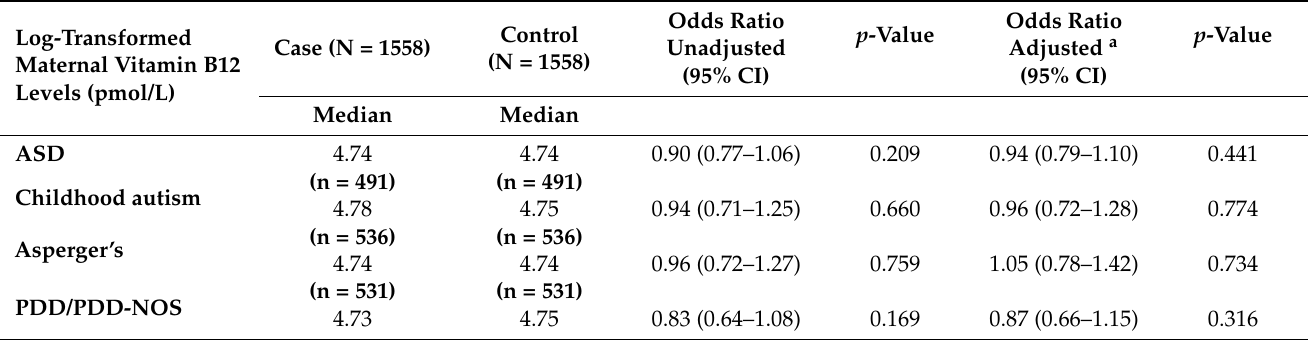
Table 3. Odds ratios and 95% CIs for the association between log-transformed maternal serum vitamin B12 (continuous) and offspring ASD and